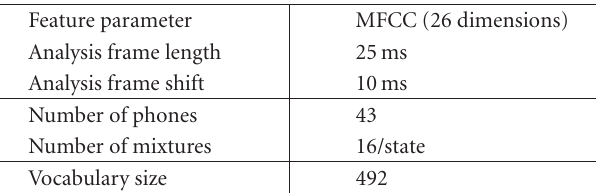
Table 1: Parameters of the speech recognizer.